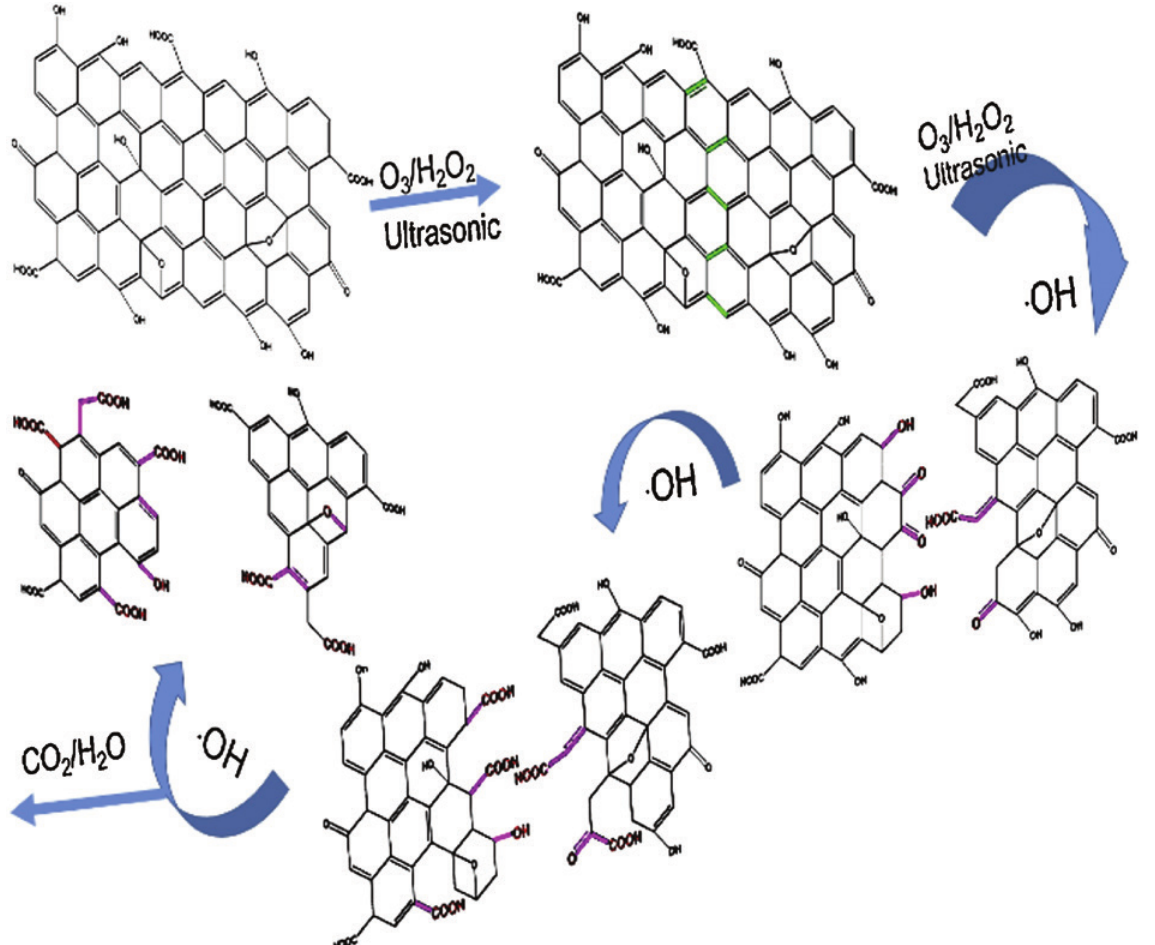
Figure 9: Schematic illustration of the possible two-step generation mechanism of GQDs (reprinted/reproduced with the permission of Ref. [83], copyright 2016, Elsevier B.V.).